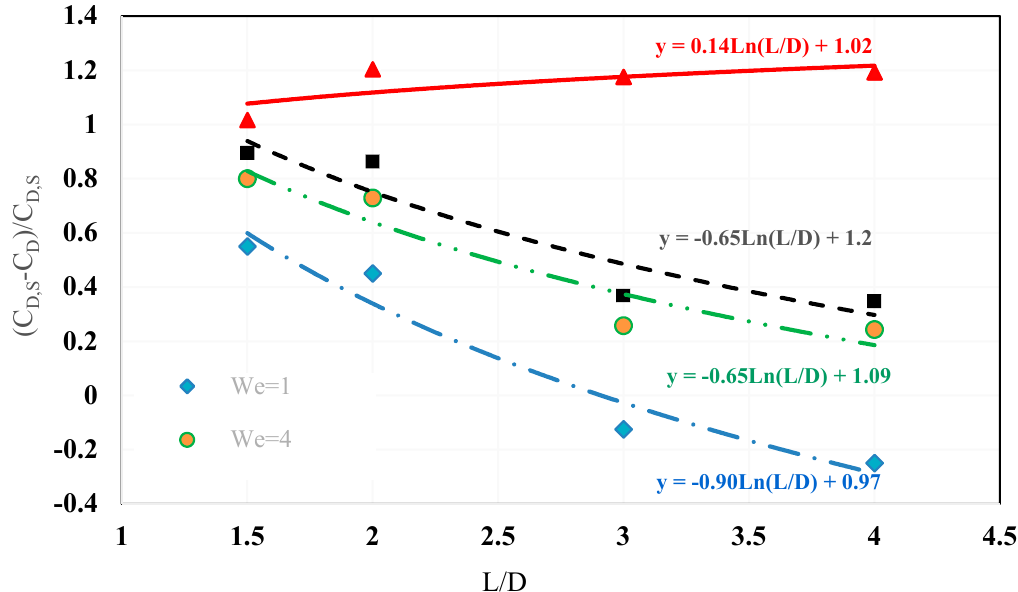
Figure 8. The deviation of the final drag coefficient between the downstream droplet and the single isolated